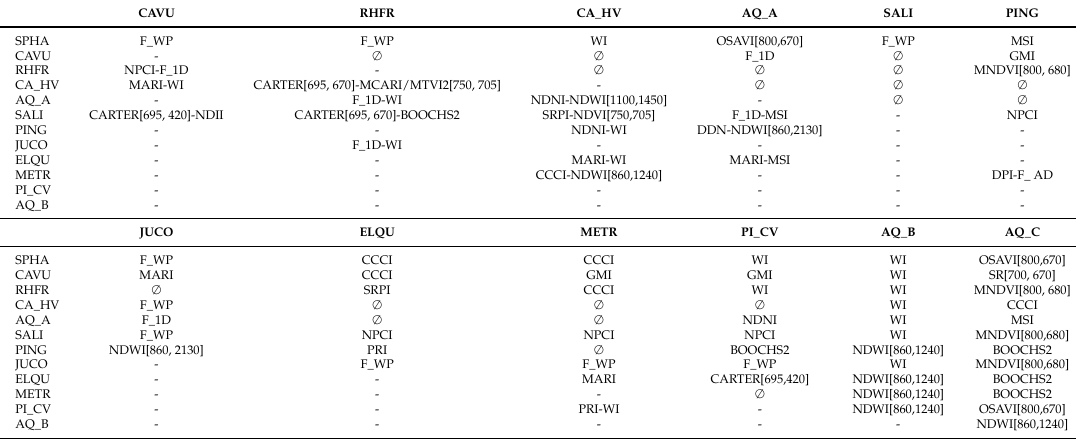
Table 12. Single spectral index or pairs of spectral indices retained to discriminate between vegetation types pairs.